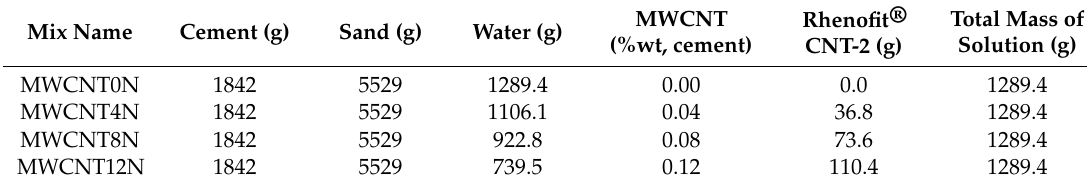
Table 7. Mix design of mortar MWCNTs added without treatment of